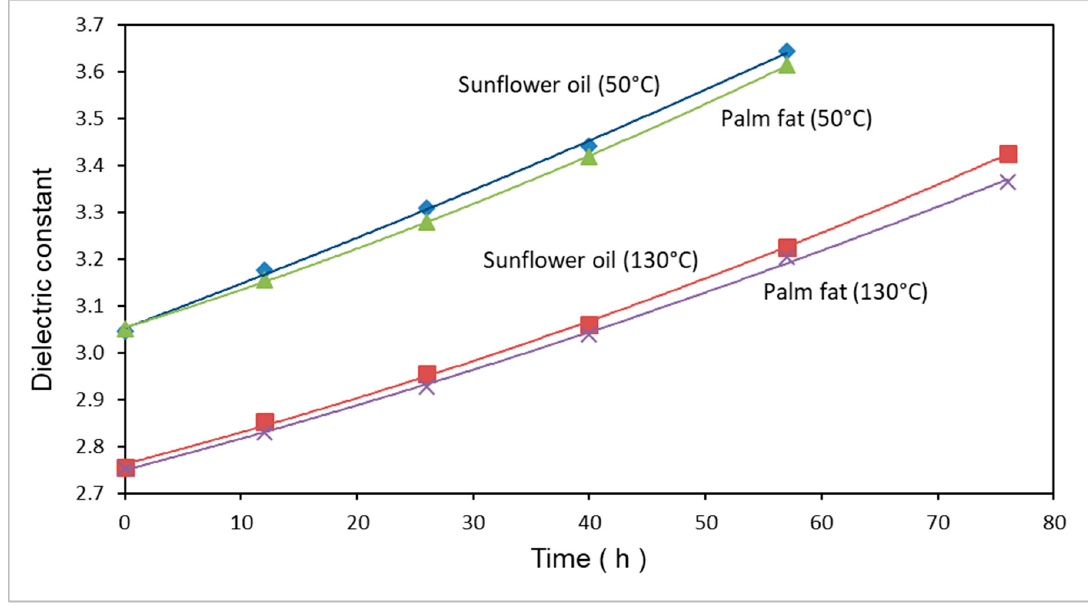
Figure 4. Dielectric constant as a function of the time of the thermo-oxidative degradation of sunflower oil and palm fat at two measuring temperatures; thermal degradation: 0–76 h at 175 ± 3 °C. The dielectric constants of the treated and untreated sunflower oil and palm fat are nearly identical at both measuring temperatures. At a measuring temperature of 130 °C, the dielectric